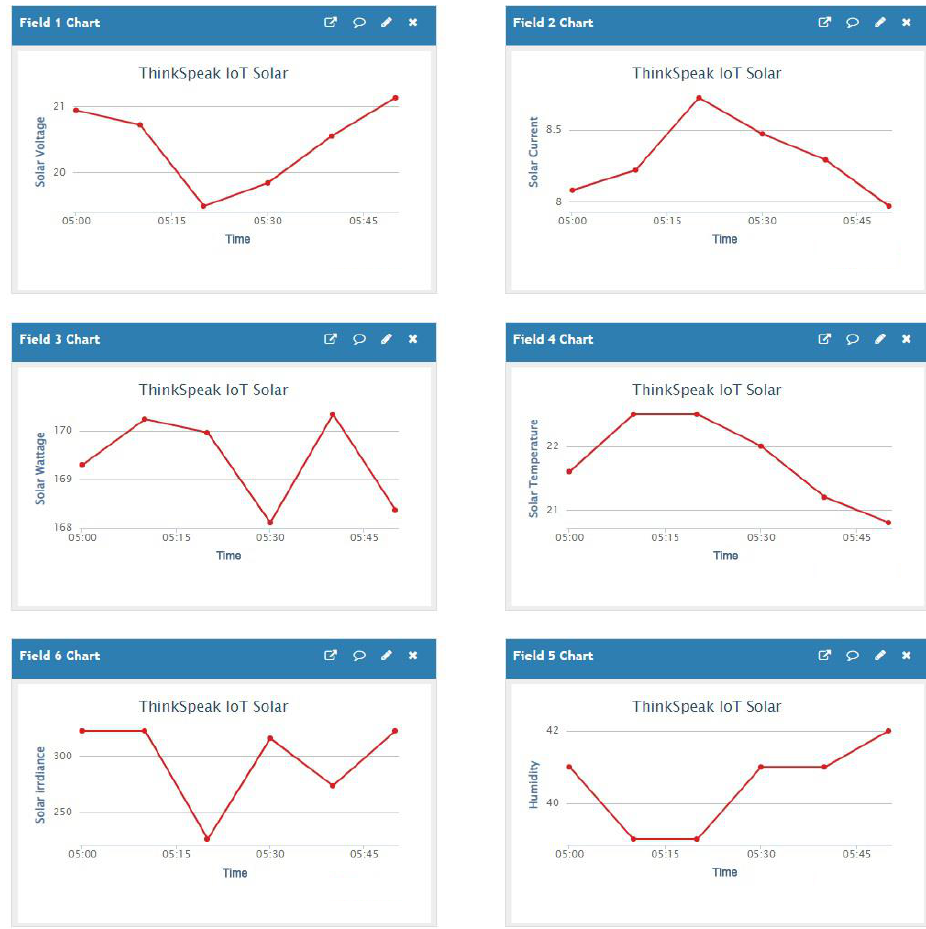
Figure 15. Real-time results for four active PV modules and one shaded.